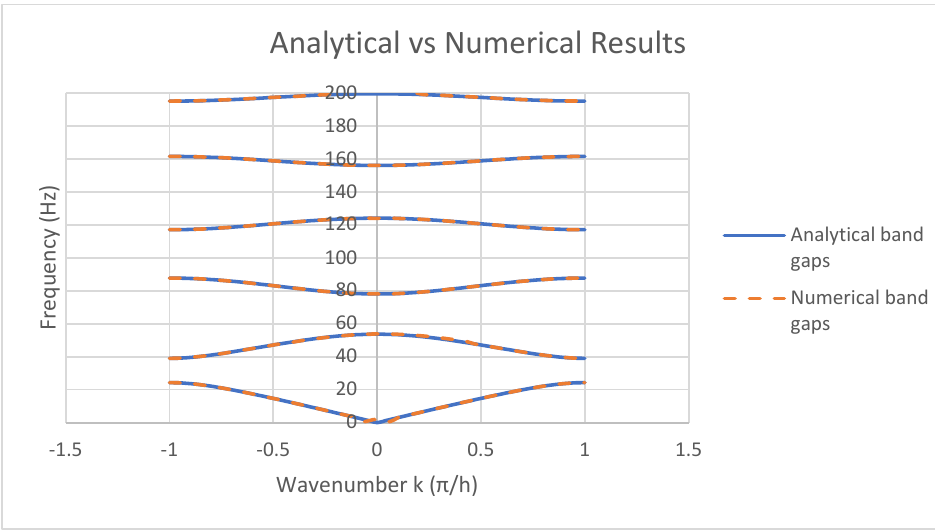
Table 2. Presentation of the first five (analytically calculated) band gaps of the meta ‐ material layout, within the desirable frequency range.